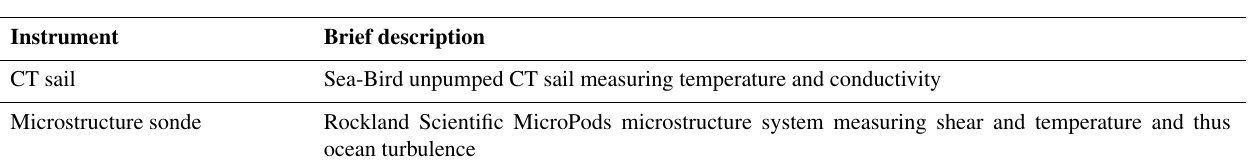
Table B19. Melonhead